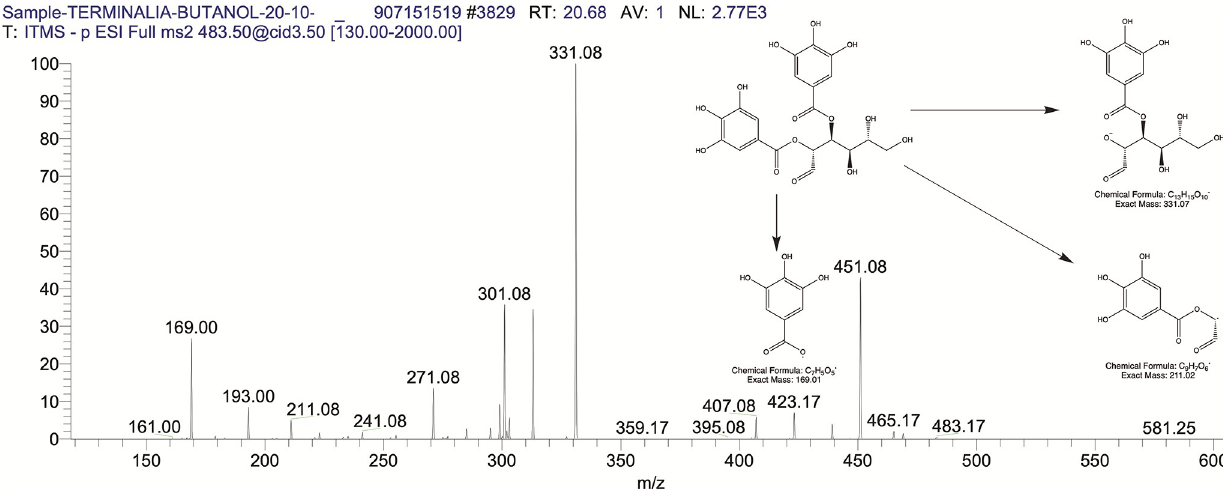
Fig 8. The mass spectrum of di-O-galloyl glucose and its fragmentation